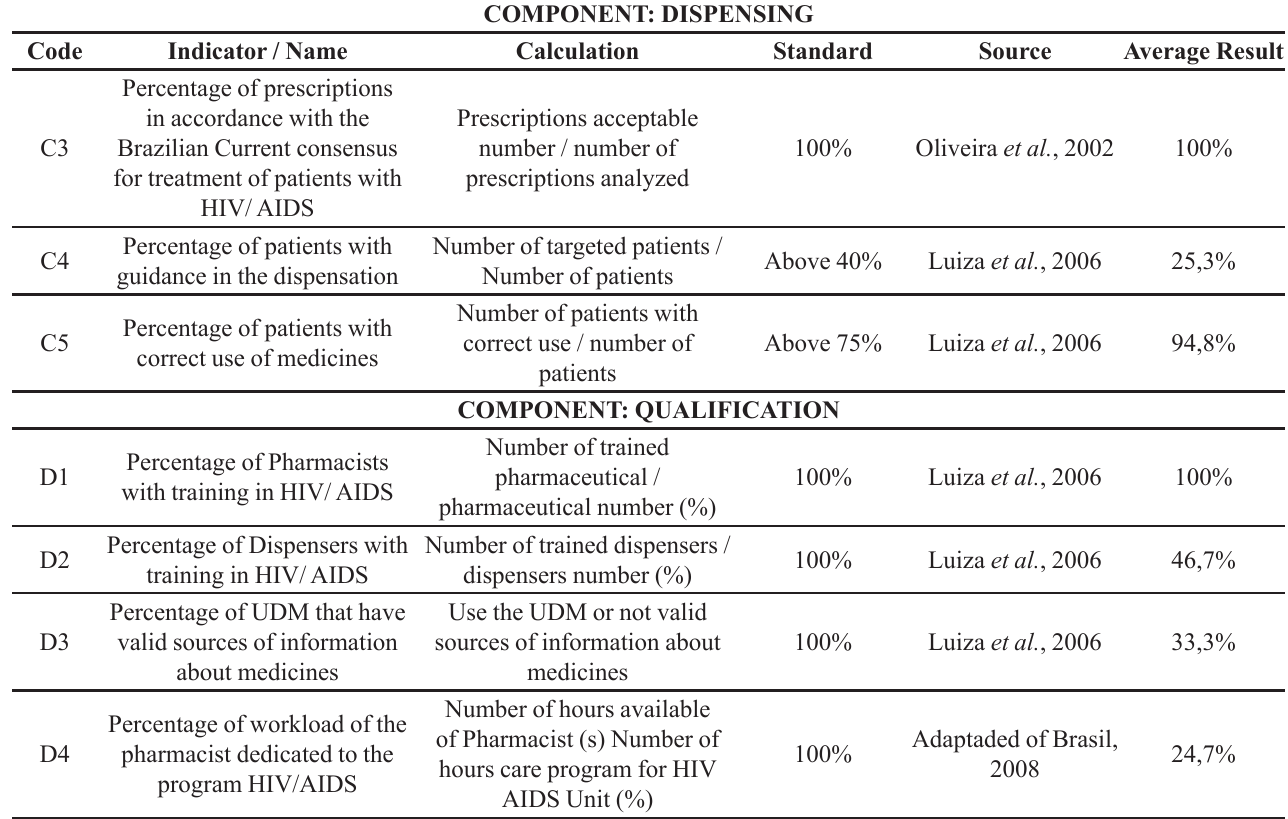
TABLE I - List of indicators used and results obtained (average results for UDM) (cont.)